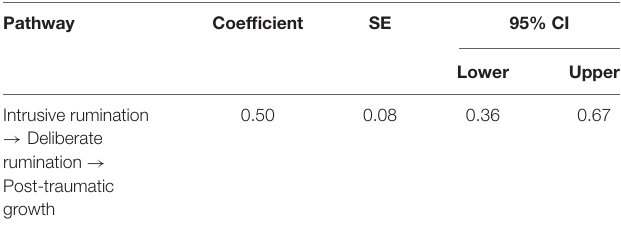
TABLE 4 | Indirect effects on post-traumatic growth